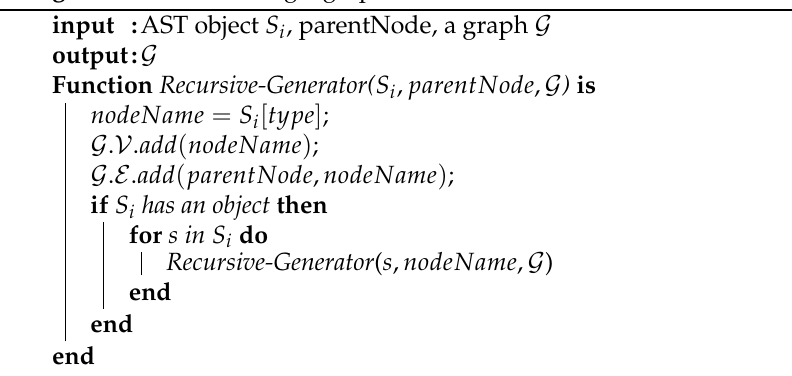
Algorithm 1: Generating a graph from an